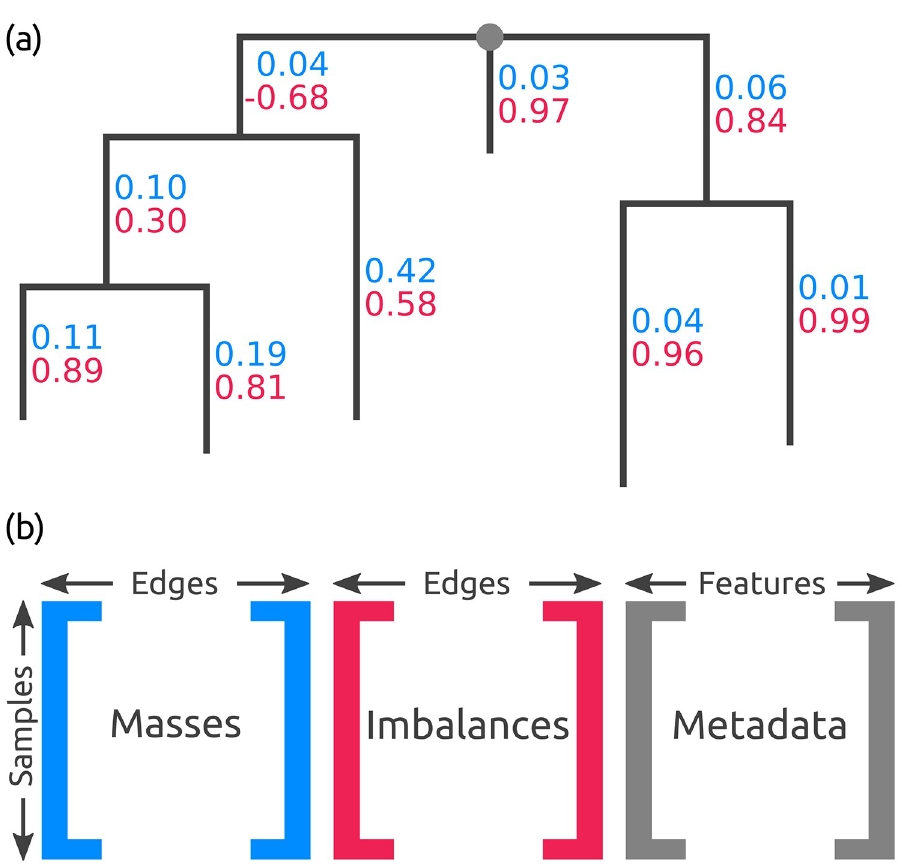
Fig 3. Edge masses and imbalances. (a) Reference tree where each edge is annotated with the normalized mass (first value, blue) and imbalance (second value, red) of the placements in a sample. The depicted tree is unrooted, hence, its top-level trifurcation (gray dot) is used as “root” node. (b) The masses and imbalances for the edges of a sample constitute the rows of the first two matrices. The third matrix contains the available meta-data features for each sample. These matrices are used to calculate, for instance, the Edge PCA or correlation